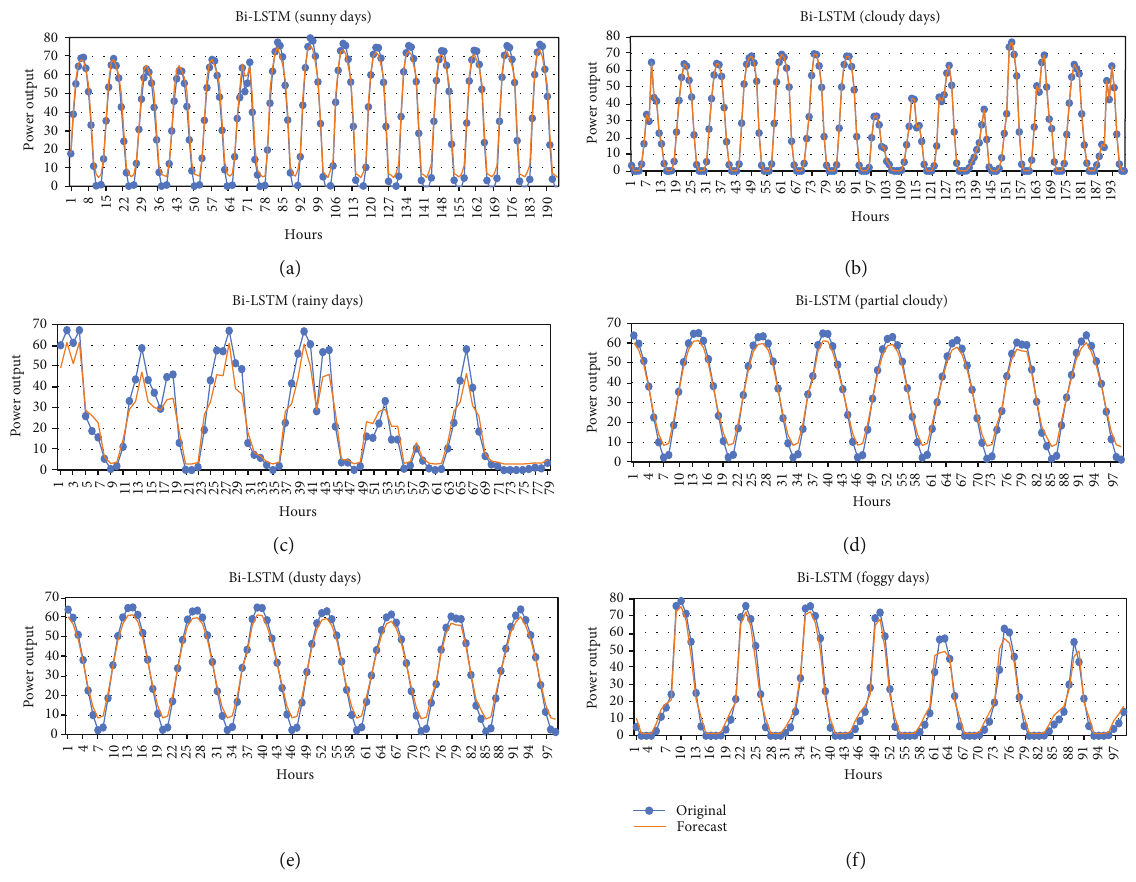
Figure 5: Bi-LSTM results for (a) sunny days, (b) cloudy days, (c) rainy days, (d) partial cloudy days, (e) dusty days, and (f) foggy